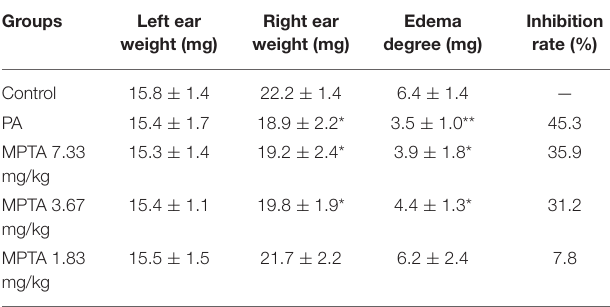
Right ear weight (mg)